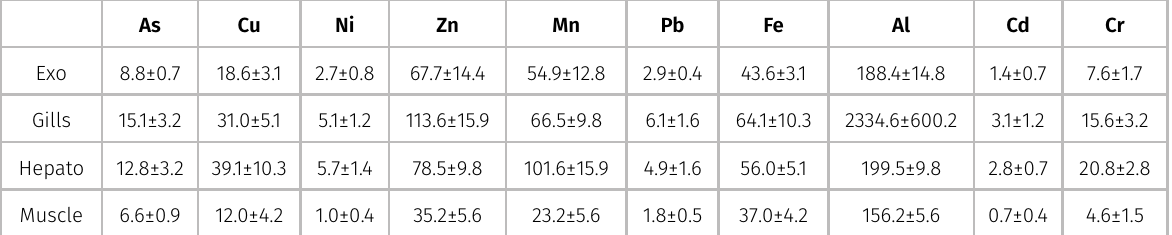
Table I. Metal concentrations in crayfish tissues (μg/g dry weight). Data are given as Mean±SE. As Cu Ni Zn